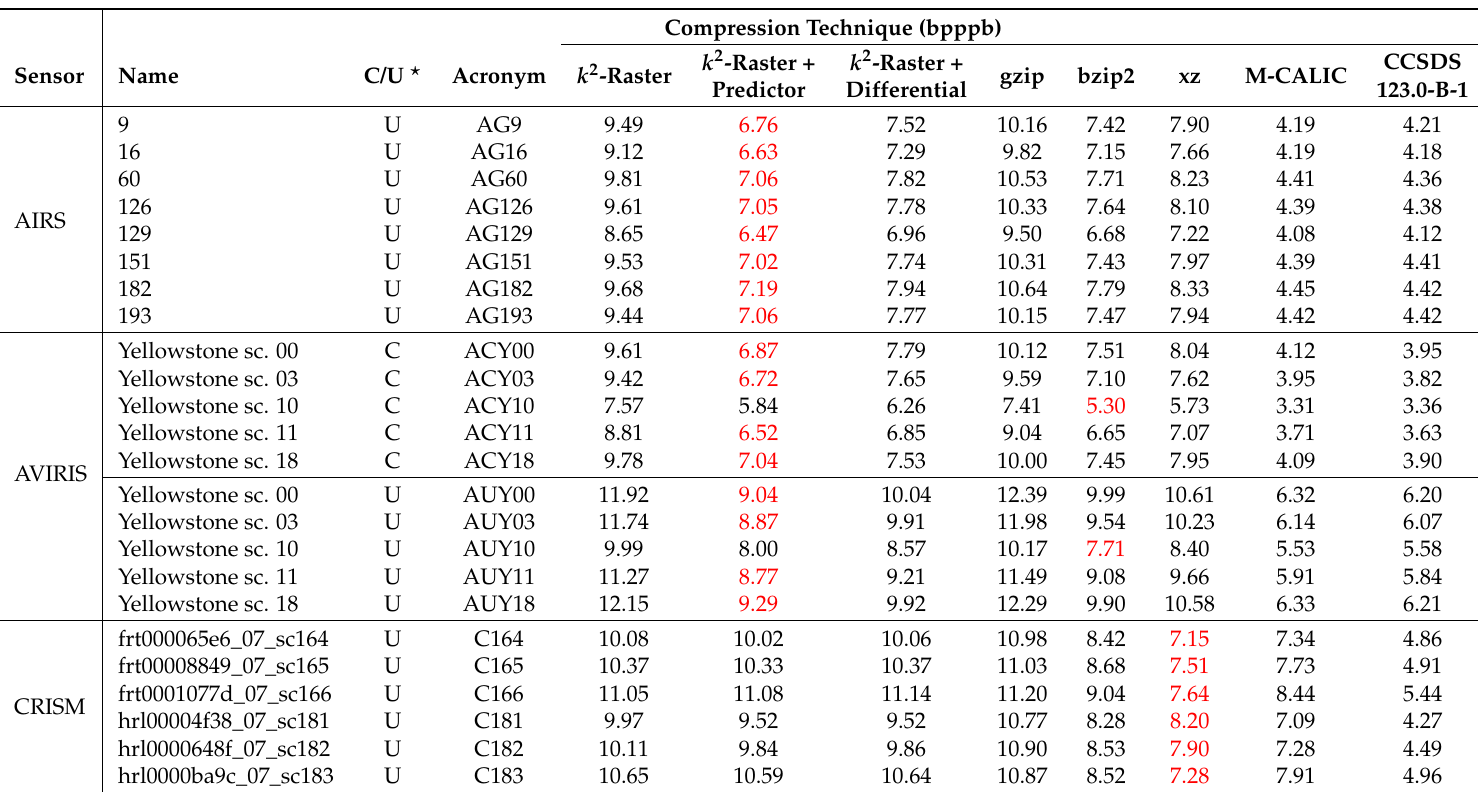
Table 2. A rate (bpppb) comparison with other compression techniques. The optimal values for all compression algorithms (except for M-CALIC, CCSDS 123.0-B-1) are highlighted in red. Results for CCSDS 123.0-B-1 are from